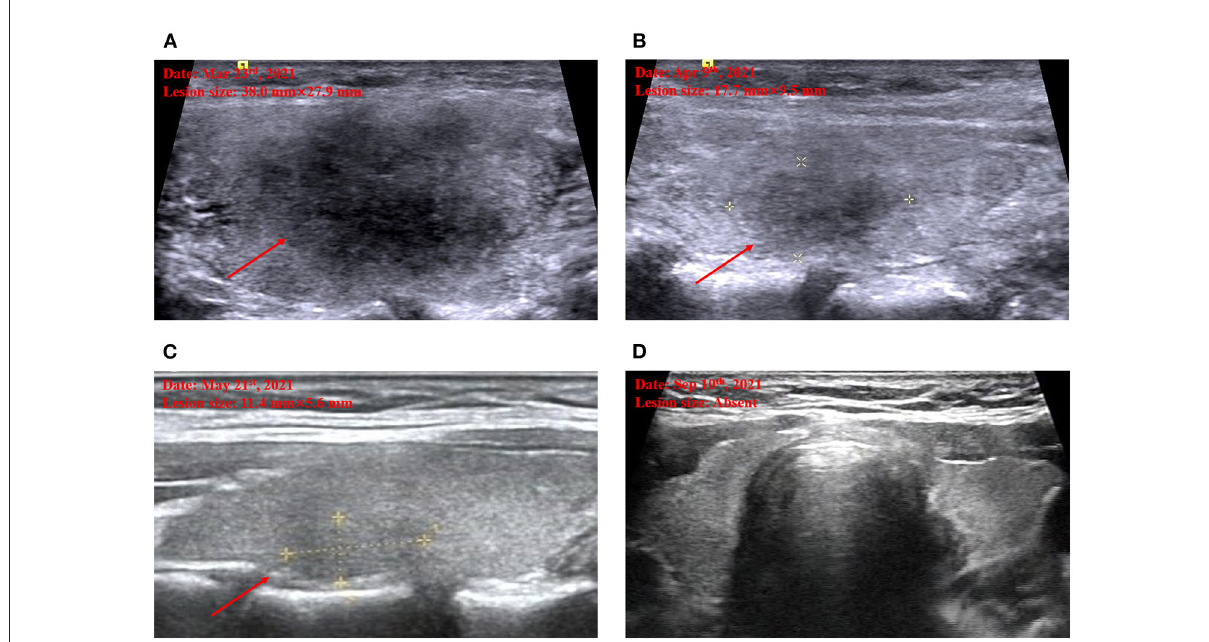
FIGURE1 Thyroid ultrasound imaging. Marked hypoechoic lesion on admission (A) . Decreased hypoechoic lesion by half when the first follow-up on April 9 (B) . Further decreased hypoechoic lesion when the second follow-up on May 21 (C) . Disappeared hypoechoic lesion when the third follow-up on September 10 (D) .